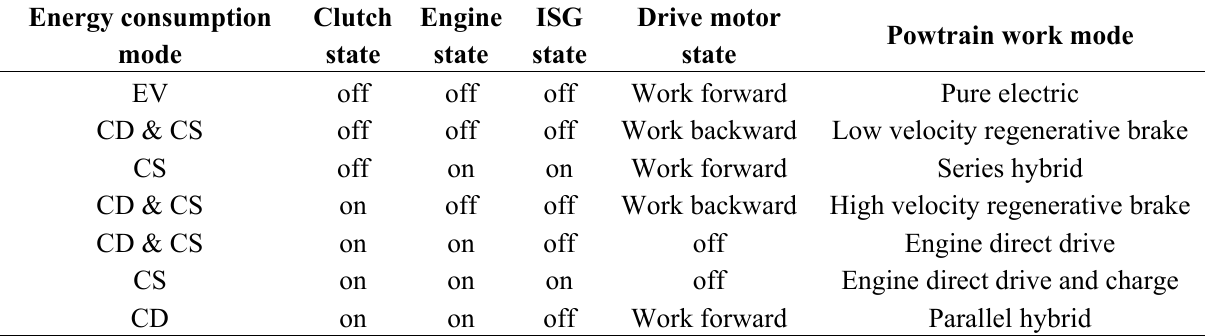
Table 2. PHSB work and energy consumption